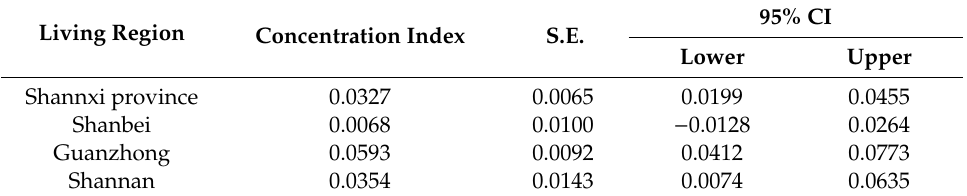
Table 4. Concentration index of the health status of the rural poor residents in di ff erent regions. Living Region Concentration Index S.E.